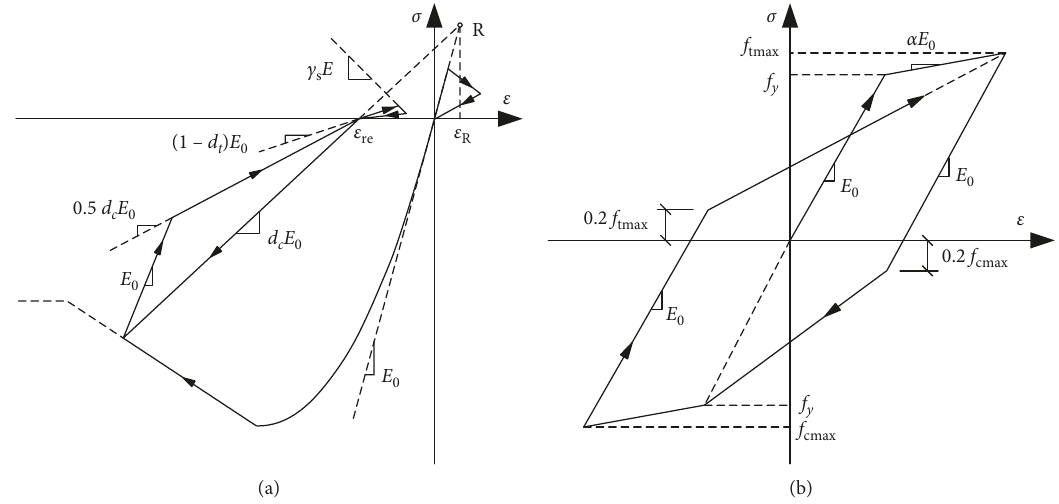
Figure 19: Materials used in the beam element. (a) Concrete02 material. (b) Modified Clough model.